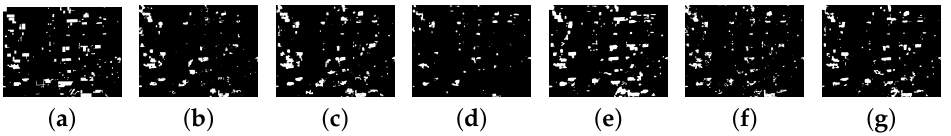
Figure 12. Result examples of different change detection algorithms on the Lasvegas of OSCD dataset. ( a ) ground truth map, ( b ) FC-Siam-conc, ( c ) FC-Siam-diff, ( d ) U-Net, ( e ) DSMS-CN, ( f ) SNUNet, ( g ) MSAK-Net-MCRF. Table 1. Experimental results of state-of-the-art methods on OSCD